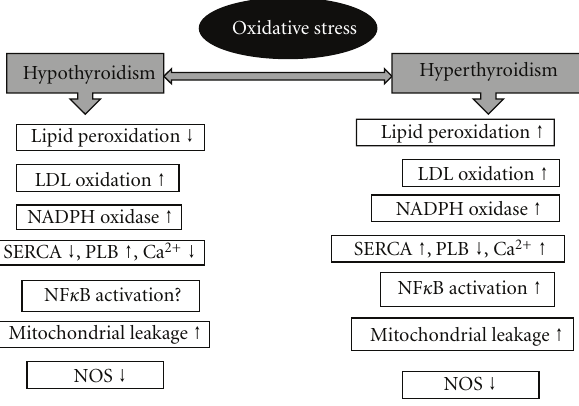
Figure 3: Cardiac oxidative stress under altered thyroid